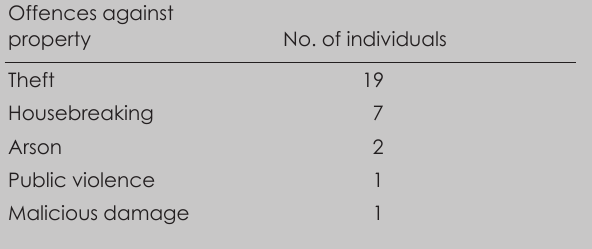
Table IV. Alleged offences against property